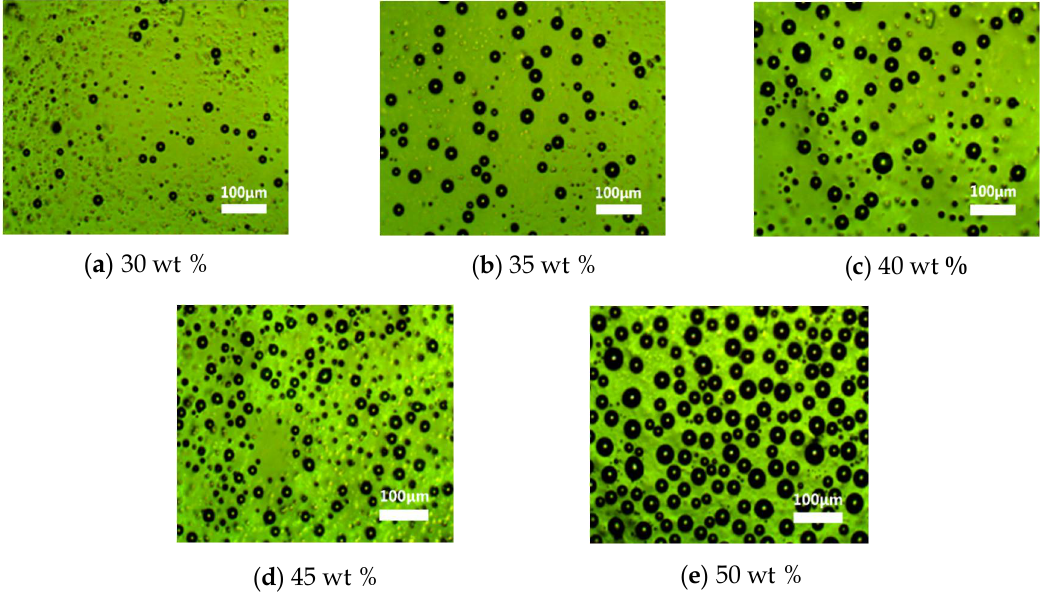
Figure 5. Morphology of the multi-walled carbon nanotubes-liquid crystal-polydimethylsiloxane (MWCNT-LC-PDMS) composite with concentrations of TS029 in PDMS of ( a ) 30 wt %, ( b ) 35 wt %, ( c ) 40 wt %, ( d ) 45 wt %, and ( e ) 50 wt %.